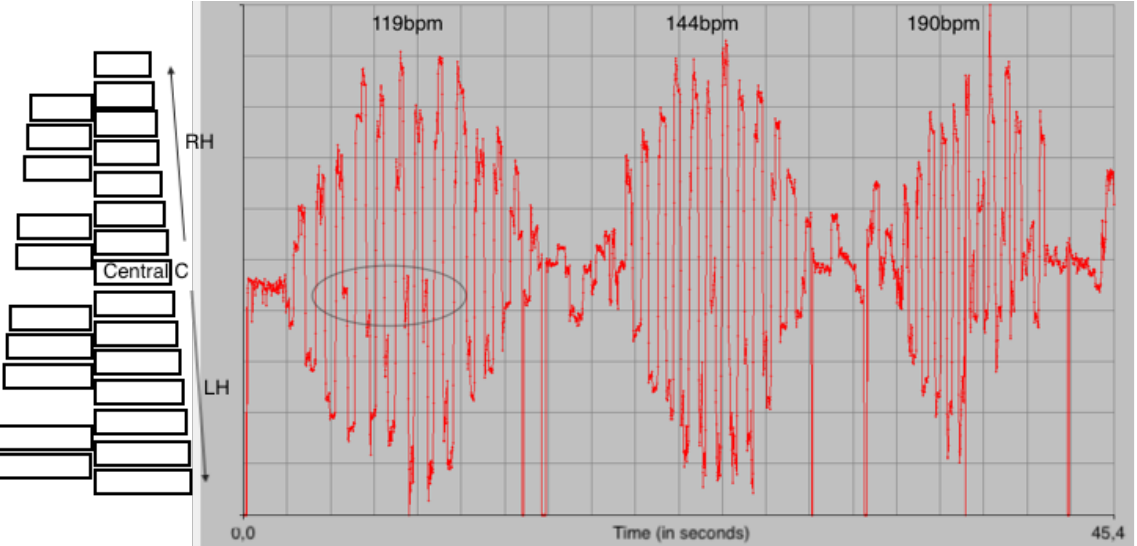
Figure 9. Representation of horizontal gaze coordinates for the contrary motion task based on a C-Major scale, performed at 3 different speeds (from slow to fast) by Player #2. The upper part of the schema represents the high register, the highest point being the highest note (towards the right of the performer), the bottom part represents the low register (towards the left of the performer) – the drawing on the left represents a top-view of the keyboard. At the slowest speed, 119bpm (left), the musician has enough time to fix on the central note (cf. circled section). At medium speed (144bpm), there is only one fixation on the centre of the keyboard, while the last iteration of the task (on the right, 190bpm) leads to a loss of control of gaze accuracy – which, in this case, takes place on the non-dominant hand side of the player, before fixing only on the central note of the exercise, C.